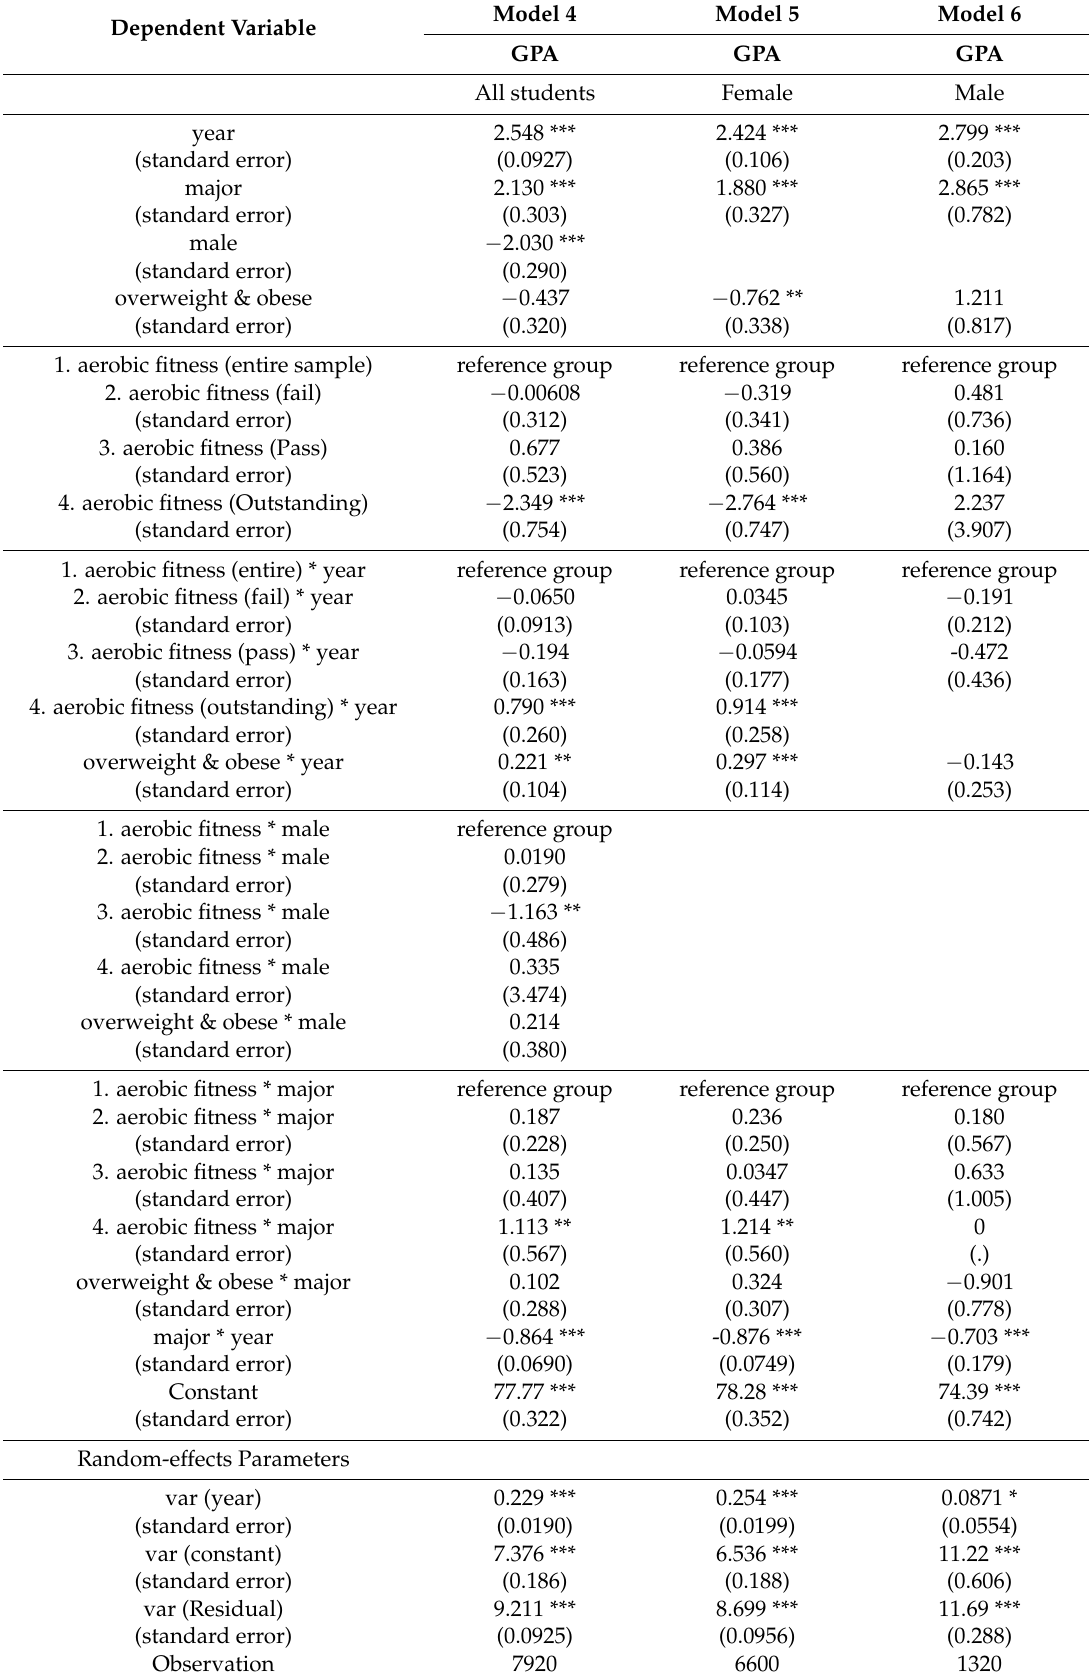
Table 3. Results of multilevel